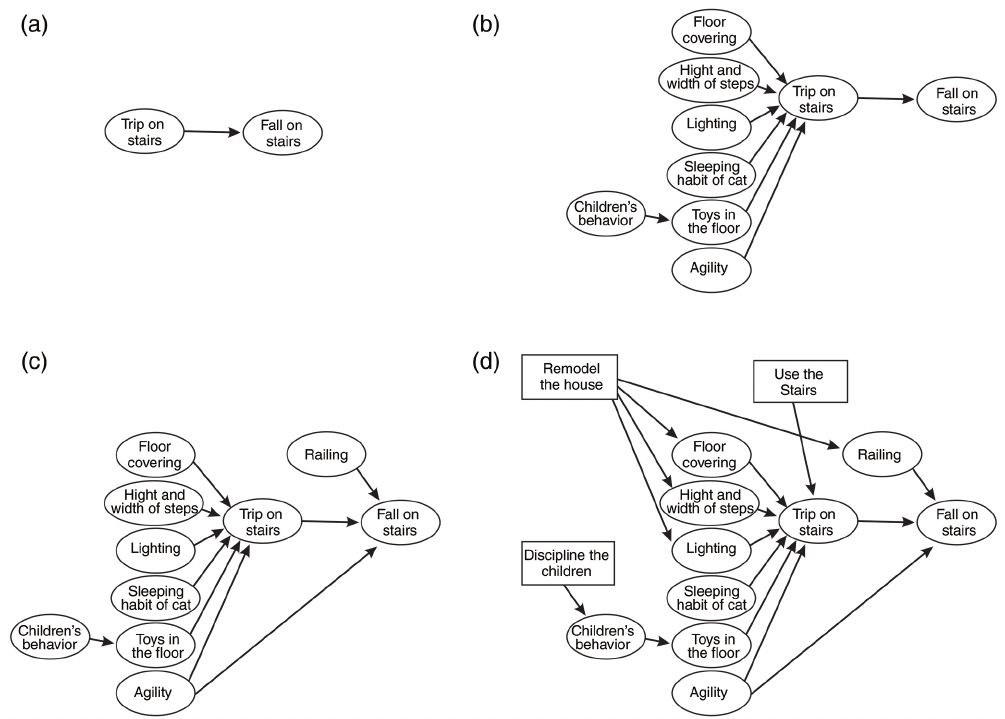
Figure 2. Illustration of the construction of an influence diagram for the risk of tripping and falling on the stairs: (a) shows just those two elements; (b) adds factors that could cause a person to trip; (c) adds factors that might prevent a fall after a person trips; and (d) introduces decisions that a person could make that would influence the probabilities of tripping and falling (Morgan et al., 2002, p.